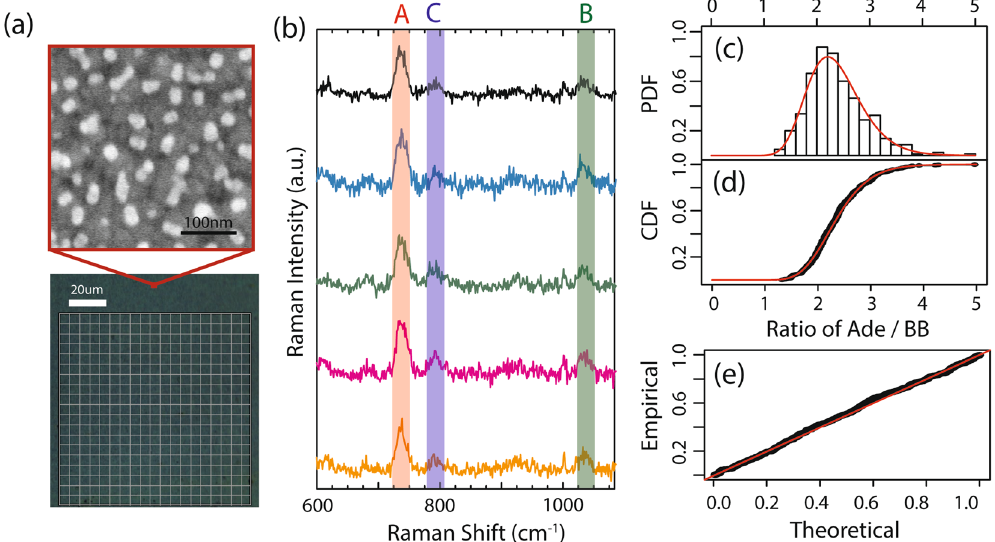
Figure 2. Random Raman mapping of ssDNA funtionalized to silver films. ( a ) Scanning electron microscope image of random silver films grown on mica and bright field image of ssDNA functionalized to random silver films on mica with the outline of the Raman map, in which 400 measurements are acquired in an approximately 100 micron by 100 micron area. ( b ) Example Raman spectra for 5 measurements of 75% A/25% C ssDNA mixture functionalized to random silver films, with the adenine ring-breathing-mode (red, 735 cm − 1 ), cytosine ring-breathing-mode (blue, 795 cm − 1 ), and backbone mode (green, 1035 cm − 1 ) labeled. ( c ) Probability density function (PDF) of the A/B ratio for the 75% A/25% C mixture, showing the best fit lognormal distribution with a lognormal median at A/B = 2.36. ( d ) Cumulative distribution function (CDF) of the 400 Raman measurements (black), with the calculated lognormal distribution (red). ( e ) Probability-probability plot visually demonstrating the goodness of fit with a lognormal